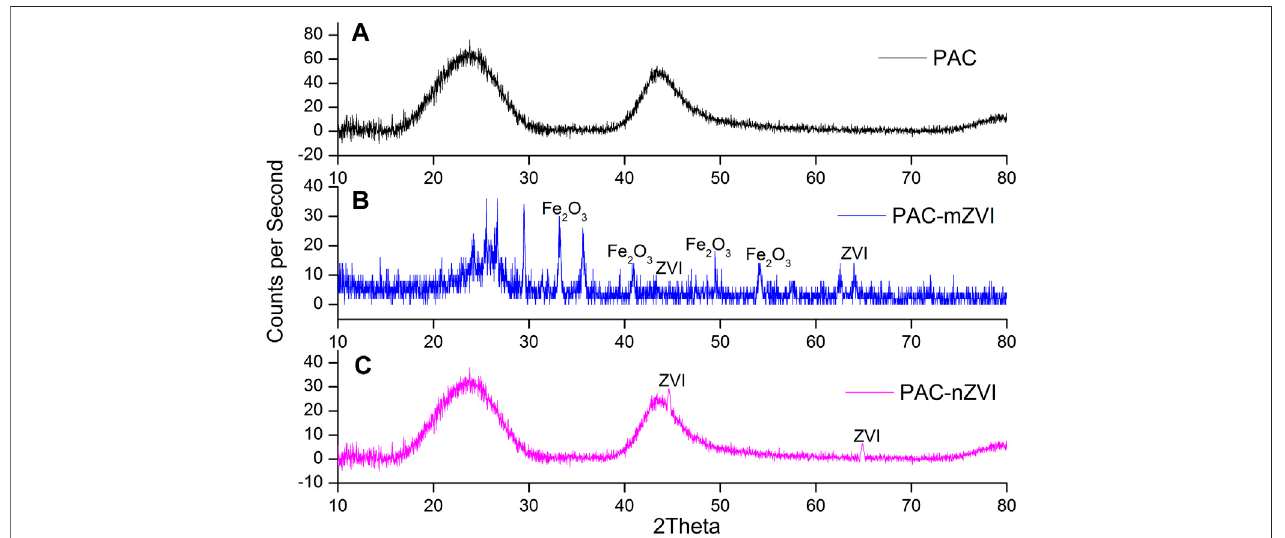
FIGURE 3 | X-ray diffractograms of three different adsorbents. (A) PAC, (B) PAC-mZVI, and (C) PAC-nZVI.